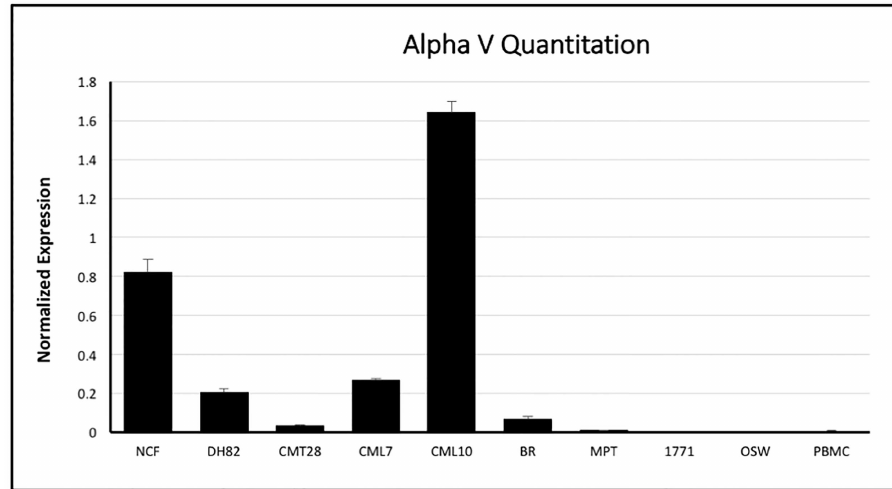
Fig 5. Quantitative RT-PCR analysis of alpha V membrane integrin mRNA in canine non-cancerous (NCF and PBMC), non-hematopoietic origin cancer (CMT28, CML7, and CML10), and hematopoietic origin cancer (DH82, 17–71, OSW, MPT-1, and BR) cells using specific primers. Alpha V mRNA expressionlevels were normalized to levels of control β -actingmRNA expression and quantifiedusing the Δ Ct